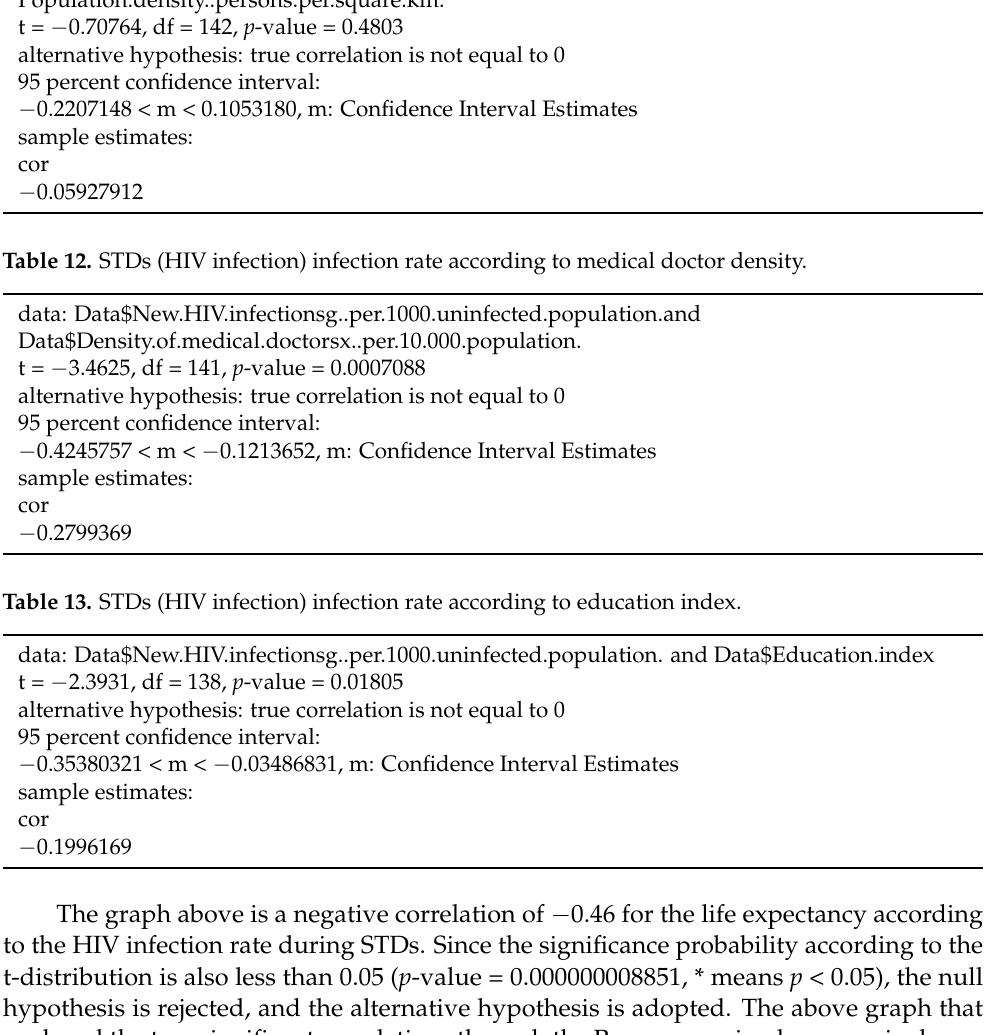
Table 11. STDs (HIV infection) infection rate according to population density. data: Data$New.HIV.infectionsg.per.1000.uninfected.population.andData$